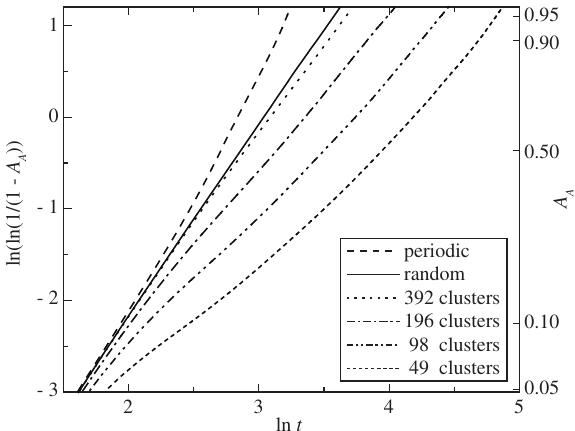
Figure 2. Area fraction against time, simulated by CA. Data from Figure 1 is replotted in the classical way. For random nuclei the line is straight, clustering makes the lines to